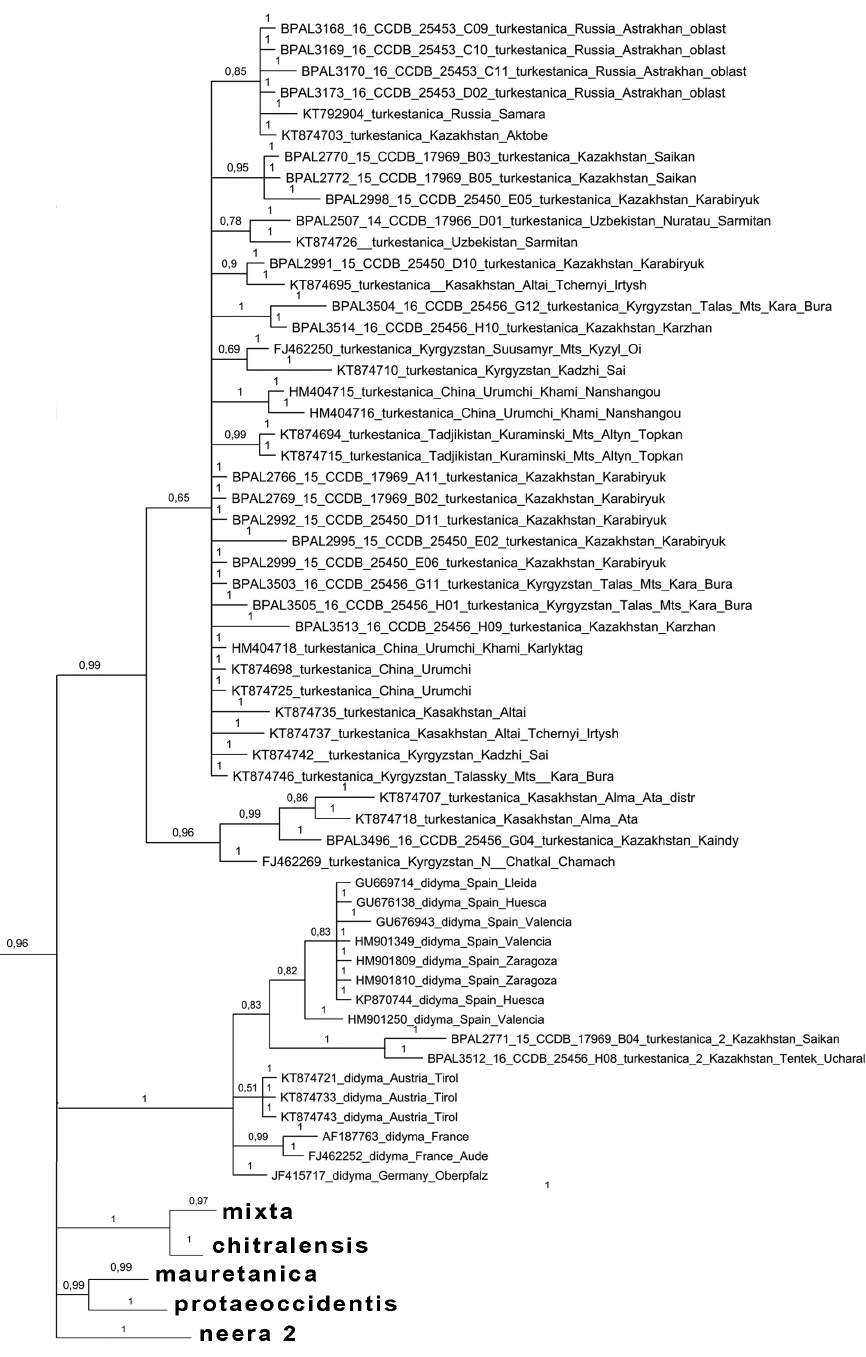
Figure 5. Fragment of the Bayesian tree of Melitaea didyma complex (haplogroups turkestanica , turke- stanica 2 , didyma ) based on analysis of COI gene. Numbers at nodes indicate Bayesian posterior